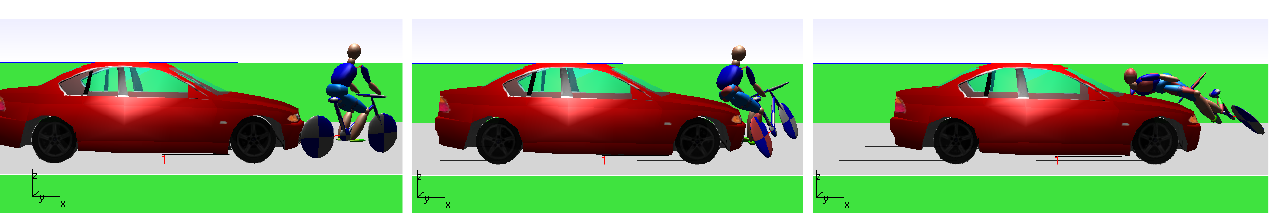
Figure 4. The positions of the car and the cyclist during the impact when the angle of impact wawas 0°, 30°, 60°, or 90°.